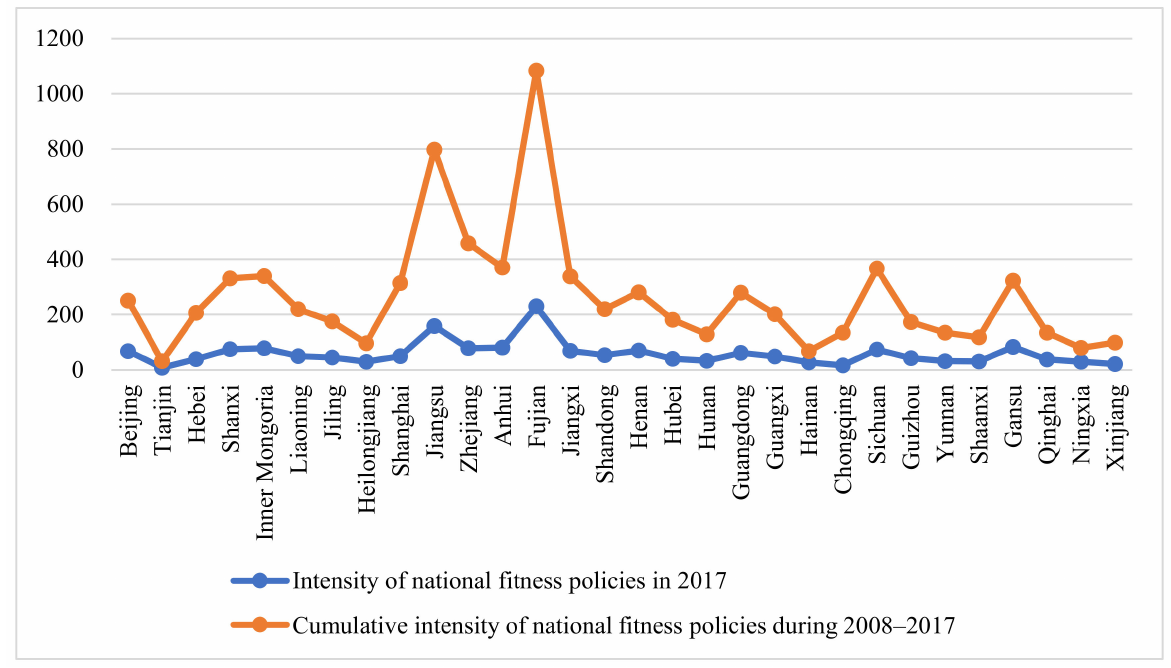
Figure 2. National fitness policy intensity and policy intensity accumulation of provinces in China in